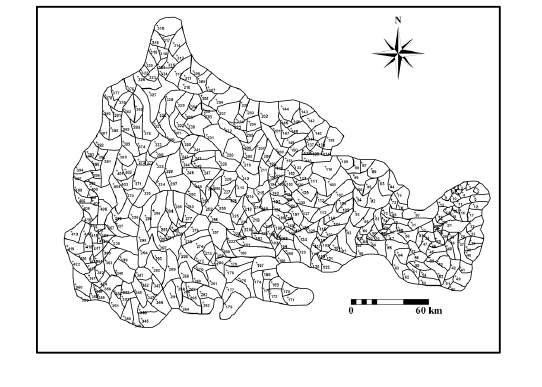
Figure 3. Sub-watershed of Indravati basin Average annual soil loss for sub-watersheds in Indravathi basin varies from 1.93 t/ha/yr to 167.29 t/ha/yr. As per the model prediction minimum soil loss occurs in sub-watershed number 407 and maximum soil loss occurs in sub-watershed number 41. Figure 4 shows distribution of the 424 sub-watersheds of